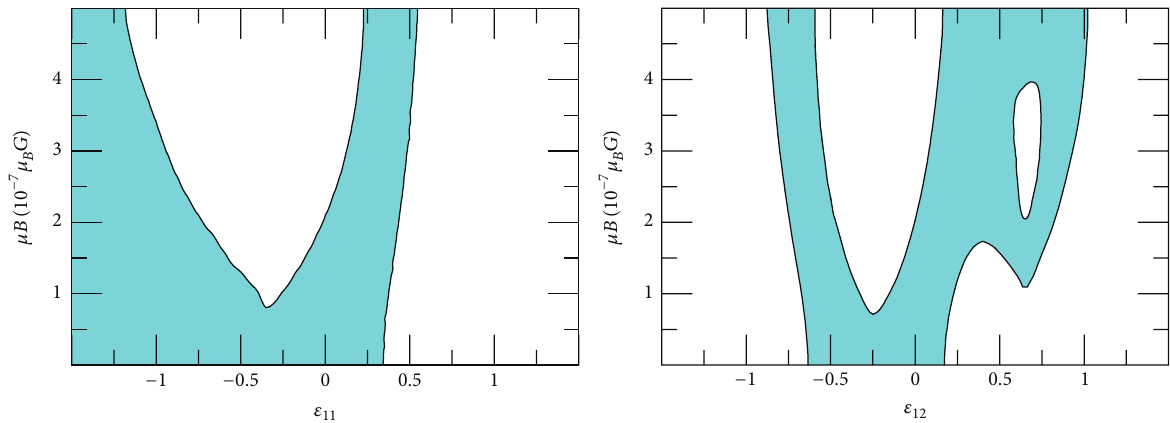
Figure 3: Allowed regions in the ( 𝜖 11 , 𝜇𝐵 ) and ( 𝜖 12 , 𝜇𝐵 ) planes at 90% CL for 10 MeV neutrino